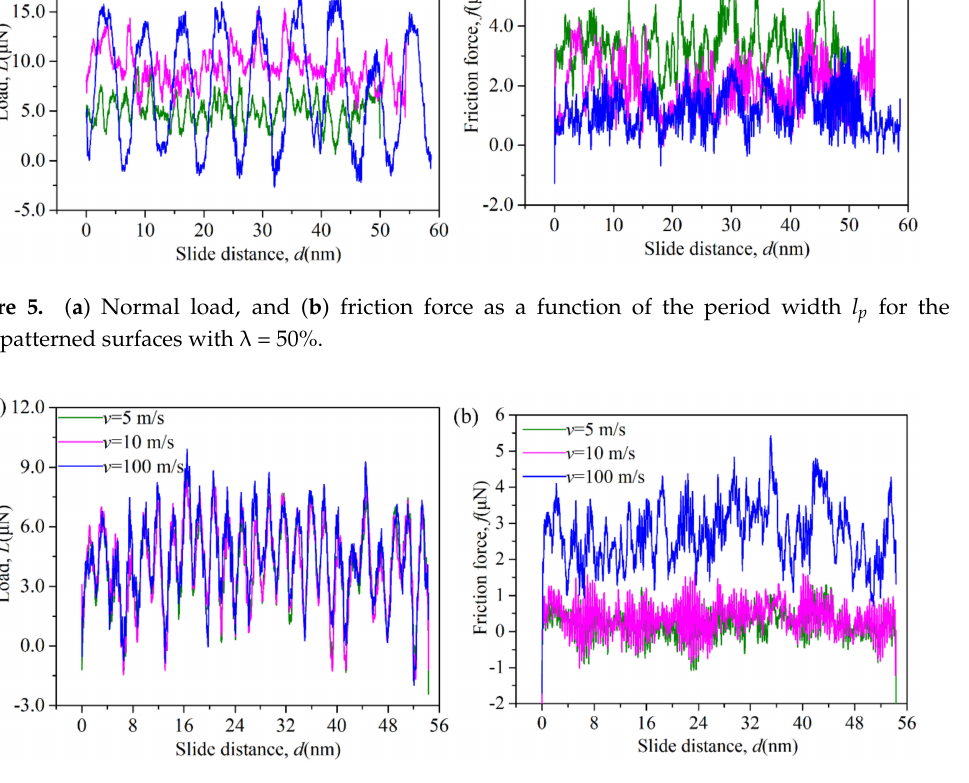
Figure 6. ( a ) Normal load and ( b ) friction force as a function of the sliding velocity for the nanopatterned surface with λ = 50% and l p = 2.17